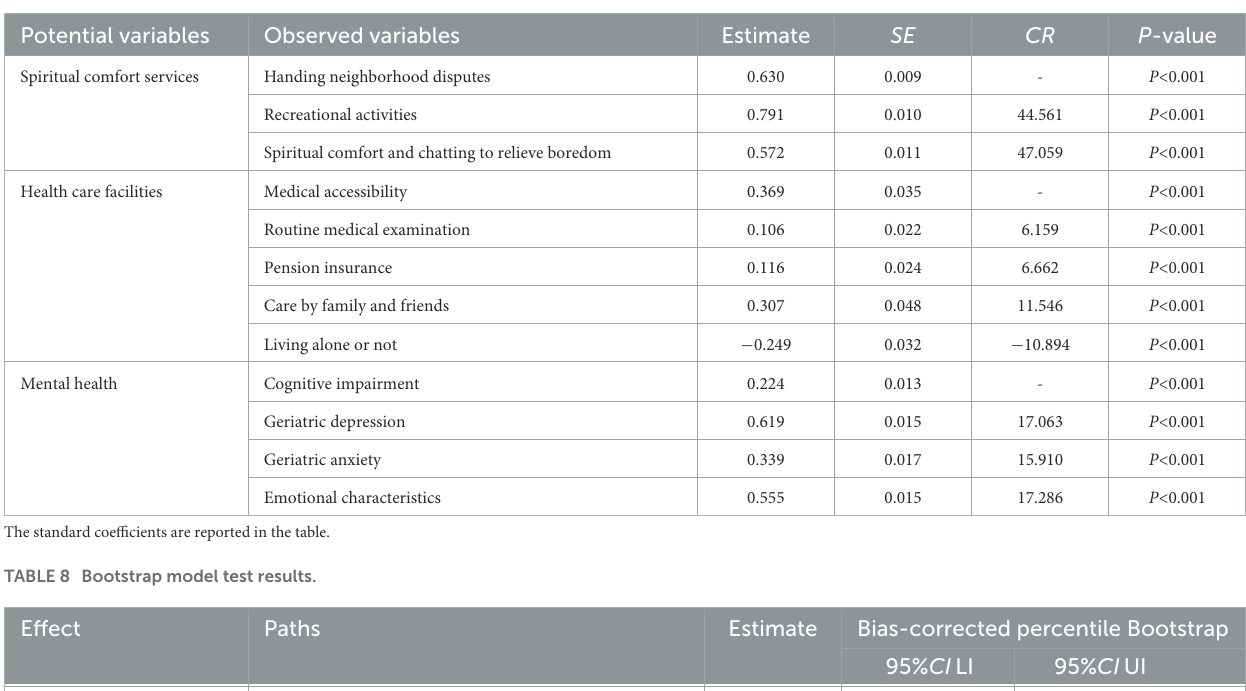
TABLE 7 Measurement model estimation results.